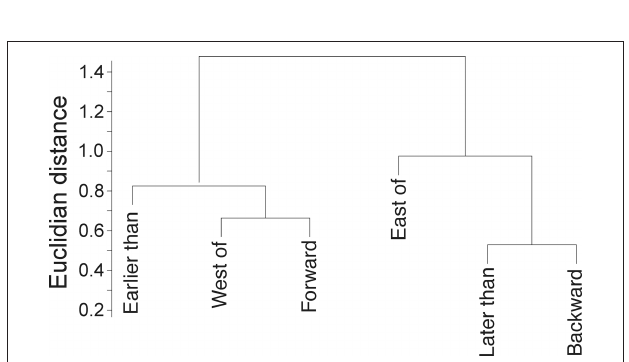
Figure 5 | The structure of the learned relation representation layer in Simulation